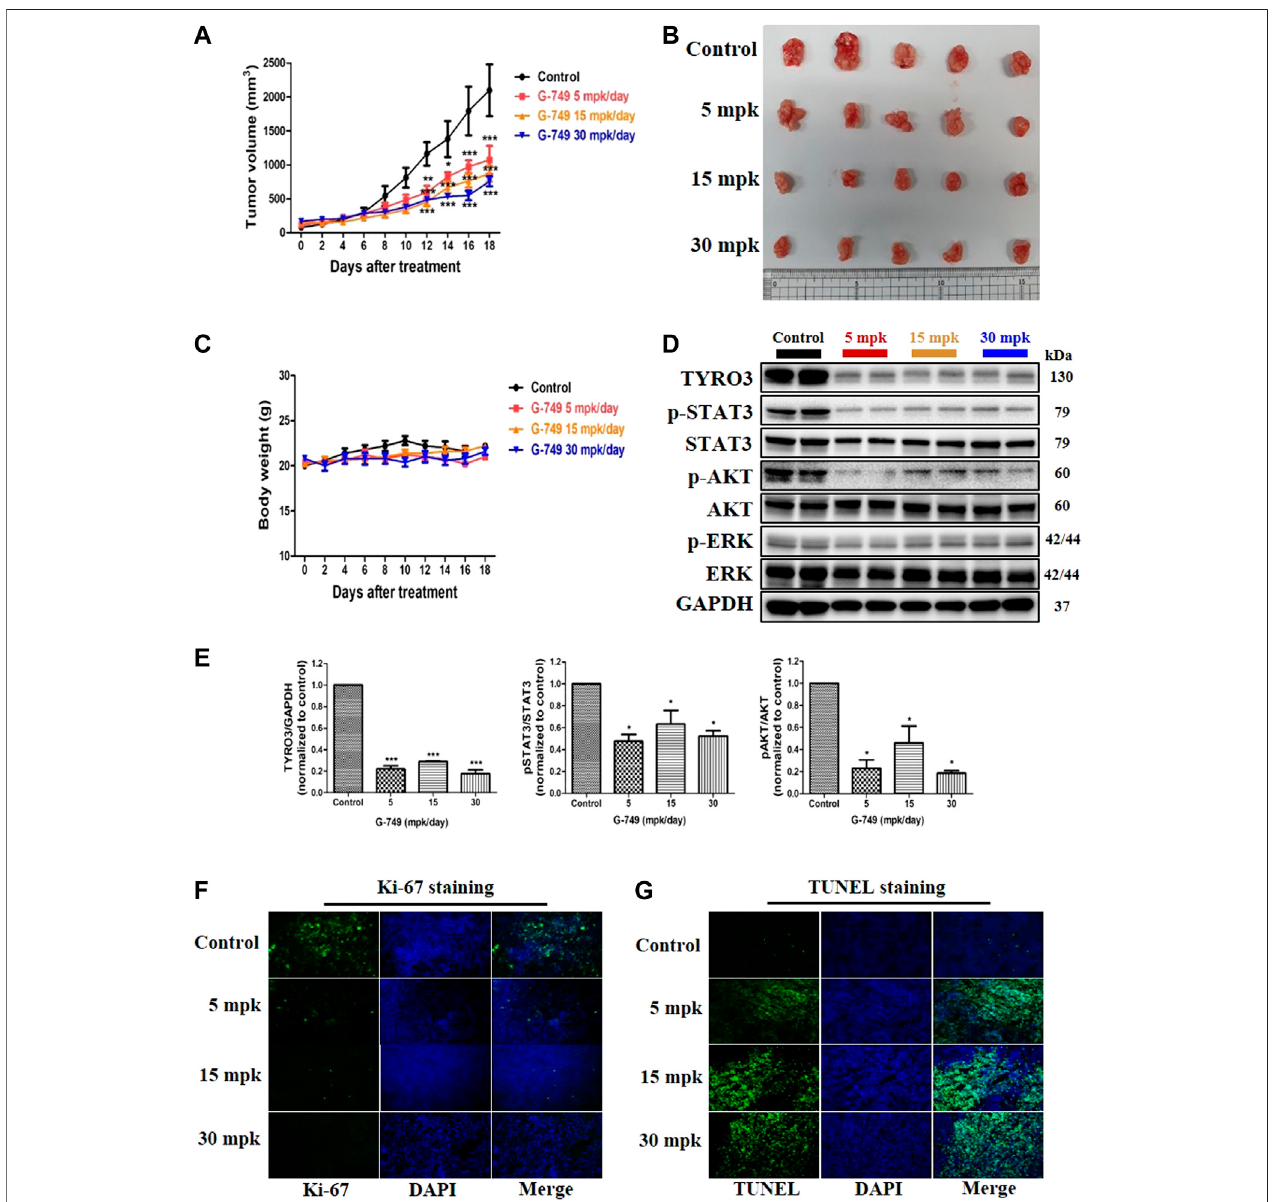
FIGURE5| G-749suppressestumorgrowth andTYRO3expressioninatumorxenograftmousemodel. (A) HCT15cellswereinoculated subcutaneouslyintothe fl anks of BALB/c-nude mice. When the tumor size reached approximately 100 mm 3 in volume, HCT15 tumor-bearing mice received oral administration of Vehicle (20% β -cyclodextrin) or G-749 (5, 15, and 30 mpk/day in 20% β -cyclodextrin) each day for 18 days. The tumor volumes were measured every 2 days ( n (cid:1) 5 mice per group). (B) RepresentativephotographsoftheexcisedHCT15tumorsfromfourgroups. (C) Thebodyweightchangewasmonitoredinthexenograftmodelthroughoutthe treatment. (D,E) Xenografttumor tissues ineach treatmentgroupwereanalyzed bywesternblotting. (F) Immuno fl uorescencewasperformedon10 μ Mthick sectioned tumor tissuestodetectKi-67protein. (G) RepresentativeimagesoftheTUNELassayonG-749treatedtumortissues.Thebargraphwasgeneratedbyquantifyingblots using ImageJ and normalizing the intensity of the bands to control. Data are presented as means ± standard deviation (SD). Data are analyzed via one-way ANOVA with Tukey ’ s multiple comparison post-hoc analysis or two-way ANOVA with Bonferroni post analysis; **** p < 0.0001, *** p < 0.001, ** p < 0.01, * p < 0.05.